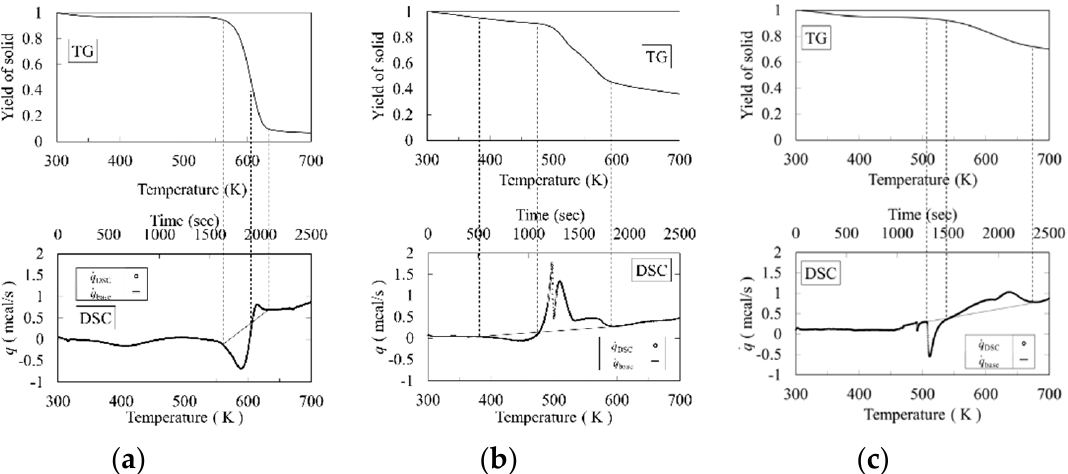
Figure 2. Results of thermogravimetory (TG) and differential scanning calorimetry (DSC) experiments. ( a ) Cellulose powder; ( b ) xylan powder; ( c ) lignin powder.